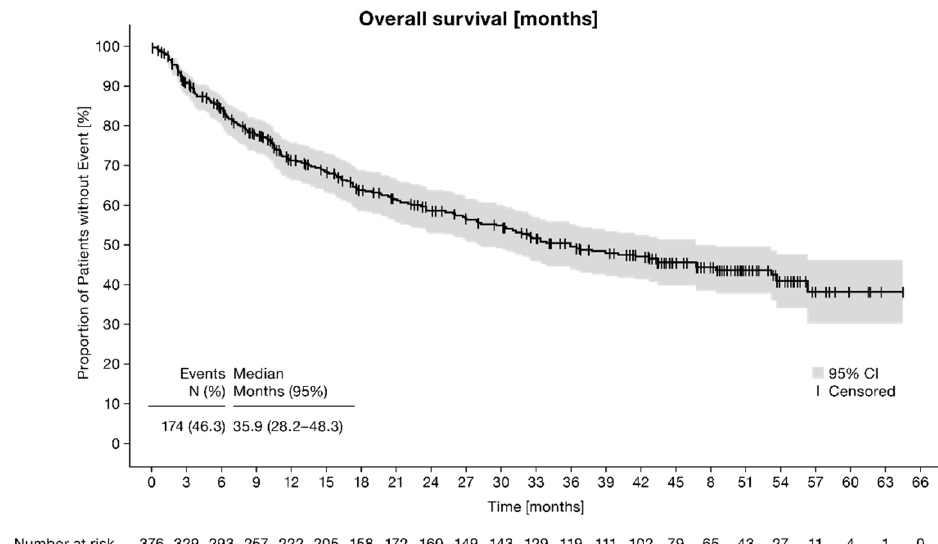
Figure 2. Overall survival of FAS-cohort I. Table 2. Sensitivity analyses for OS of FAS-cohort I on subgroup sex and age.